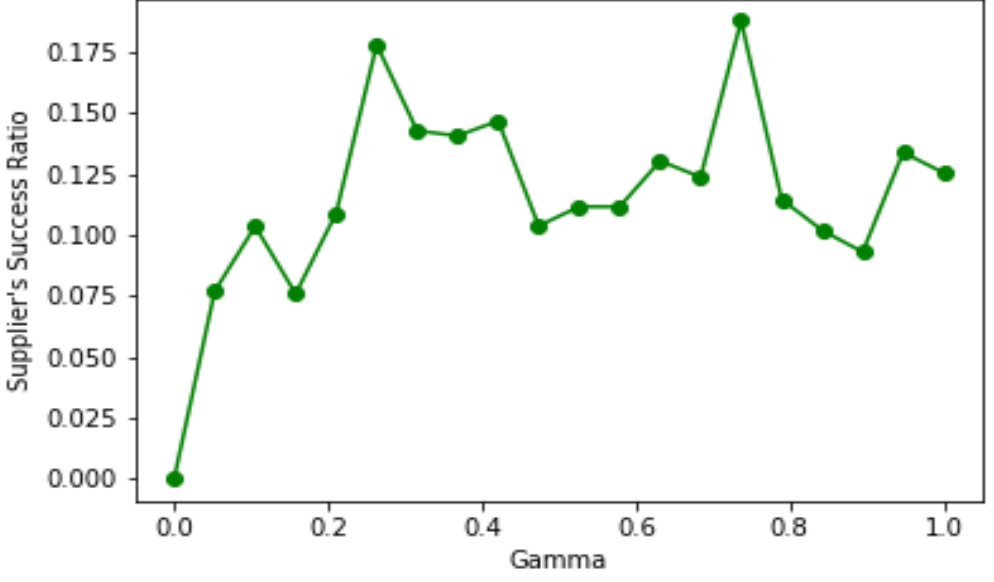
Figure 3. Effect of suspicion weight ( γ ) on supplier’s success